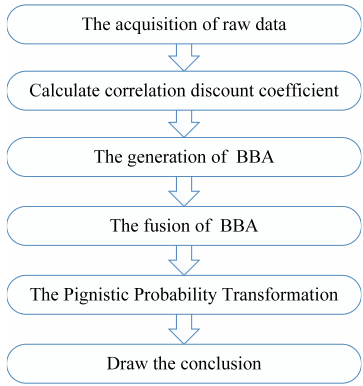
Figure 1. Flowchart of the proposed